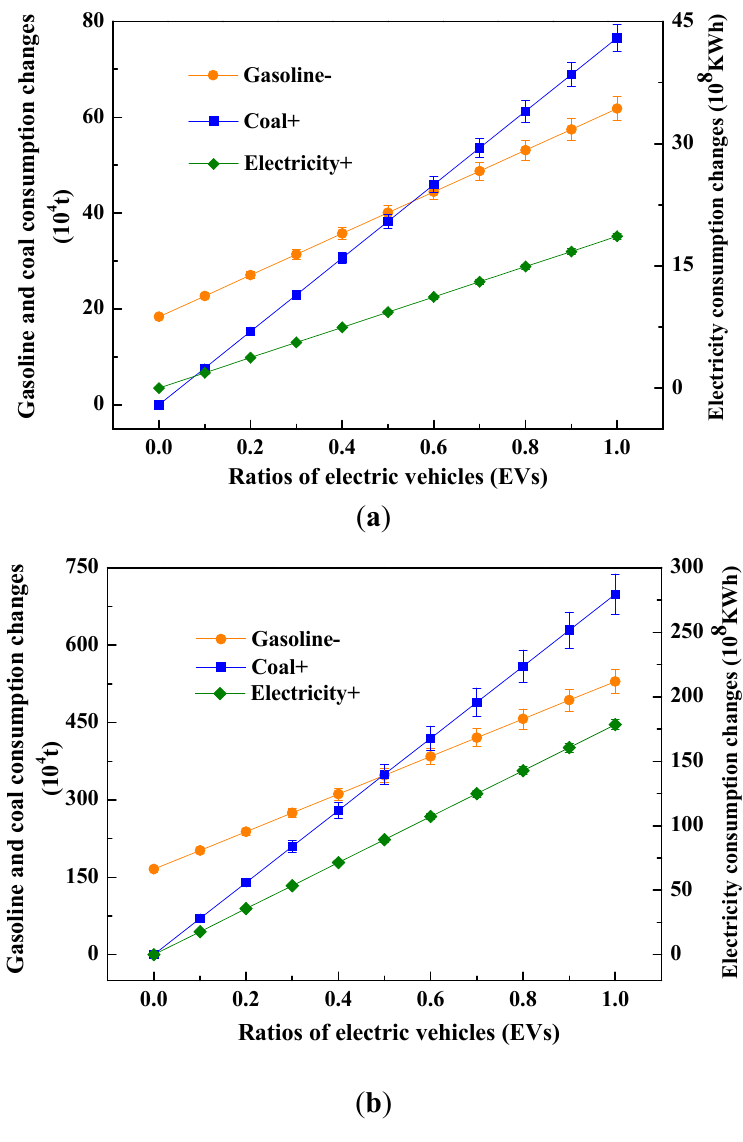
Figure 4. The consumption changes of gasoline, coal and electricity under different ratios of electric vehicles in China (“+” represents increase, “ − ” represents reduction): ( a ) 2015 and ( b )